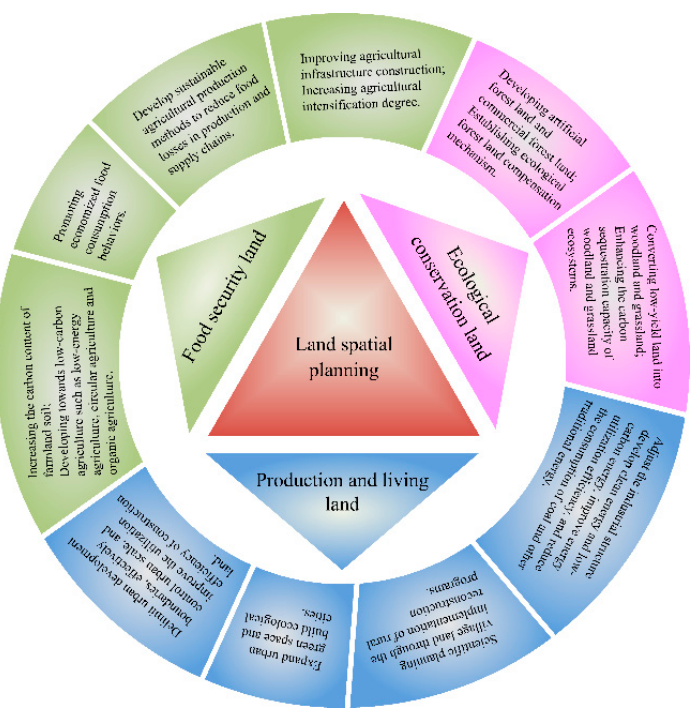
Figure 7. Suggestions for emission reduction based on land-use-related carbon storage changes.